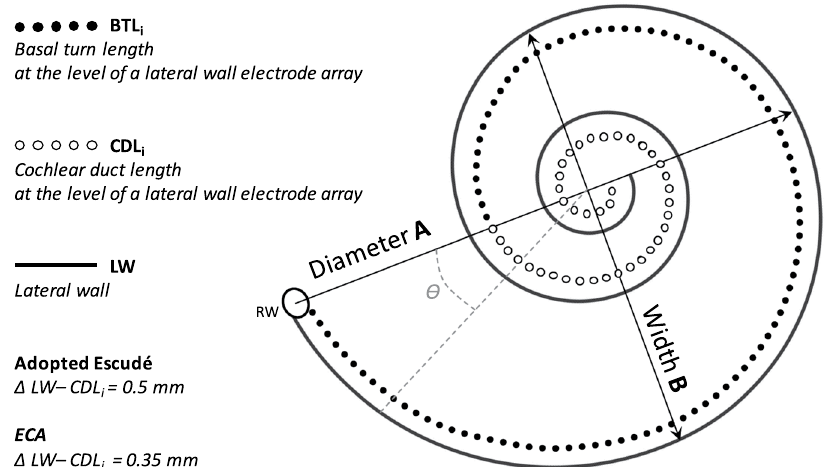
Figure 2. Schematic representation of the parameters of the cochlear duct. The lateral wall (LW), the Basal turn length (BTL) and the Cochlear duct length (CDL) at the level of a LW electrode array are shown. The arrows show the diameter ( A ) and the width ( B ) of the basal turn. The adopted Escudé approach uses 0.5 mm for the distance between the LW and the LW electrode array, while ECA uses 0.35